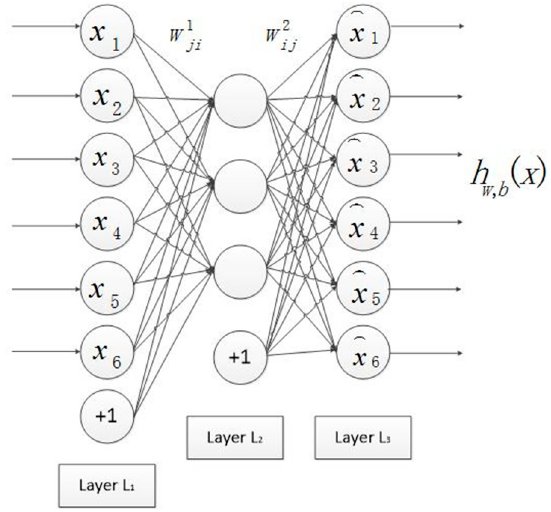
Figure 4. SA neural network structure [31].